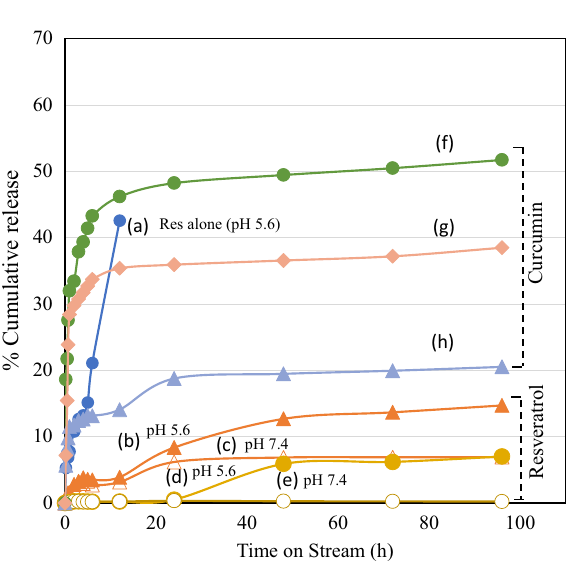
Figure 5. Release profile of antioxidants loaded nanocomposites at 37 °C for 96 h (a) Resveratrol (pH = 5.6), (b) MCM-41/ZIF-8/Resveratrol (pH = 5.6), (c) MCM-41/ZIF-8/Resveratrol (pH = 7.4), (d) KIT-6/ZIF-8/Resveratrol (pH = 5.6), (e) KIT-6/ZIF-8/Resveratrol (pH = 7.4), (f) KIT-6/Curcumin (pH = 5.6), (g) KIT-6/ZIF-8/Curcumin (pH = 5.6) and (h) MCM-41/ZIF-8/Curcumin (pH =